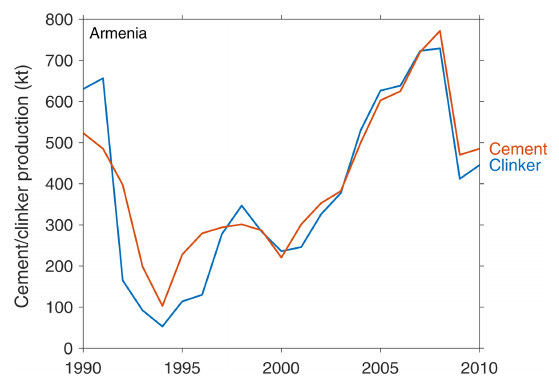
Figure D12. Clinker and cement production in Armenia, 1990– 2010 (Ministry of Nature Protection, 2014; van Oss, 2017).